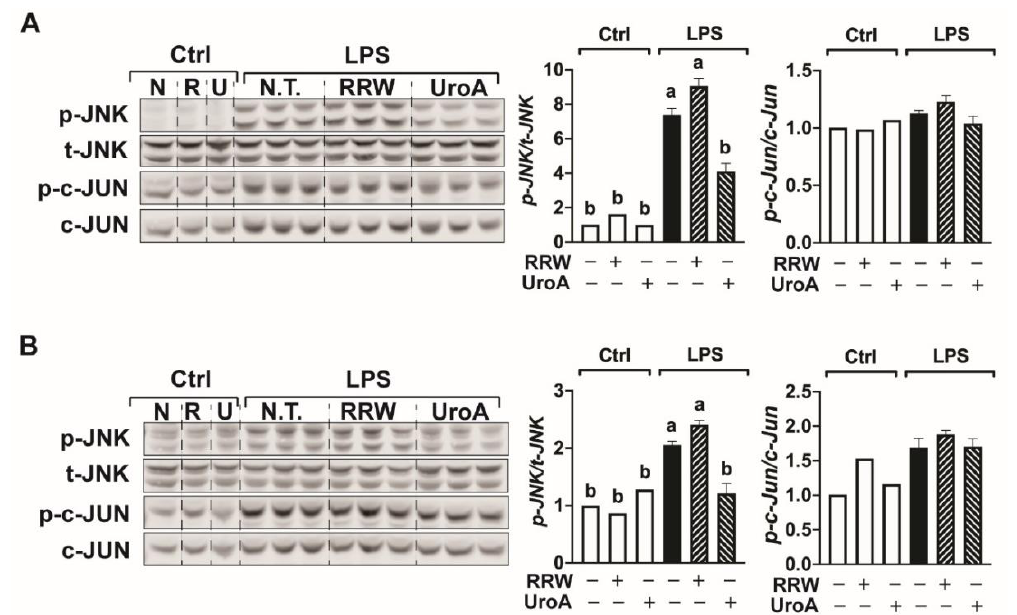
Figure 5. Urolithin A, but not whole red raspberry polyphenols, regulated the JNK signaling pathway upon 12 and 24 h LPS treatment. ( A ) BV-2 cells treated with LPS (500 ng/mL) for 12 h with or without whole red raspberry polyphenols (10 µg/mL) and urolithin A (10 µM). Protein expression from cell lysates for p-JNK, t-JNK, p-c-Jun, c-Jun by Western blot analysis. ( B ) BV-2 cells treated with LPS (500 ng/mL) for 24 h with or without whole red raspberry polyphenols (10 µg/mL) and urolithin A (10 µM). Protein expression from cell lysates for p-JNK, t-JNK, p-c-Jun, and c-Jun by Western blot analysis. Relative protein intensities normalized to total-JNK or c-Jun by LICOR Image Studio Lite (right). All values represented as the mean ± SEM. Treatments with different letters indicate significant differences by one-way ANOVA, p < 0.05. Ctrl = control; N and N.T. = no treatment; W and RRW = whole red raspberry polyphenols; U and UroA = urolithin A.